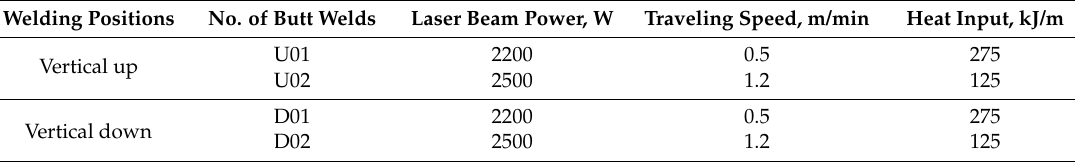
Table 2. Process parameters settings used in laser welding experiments.